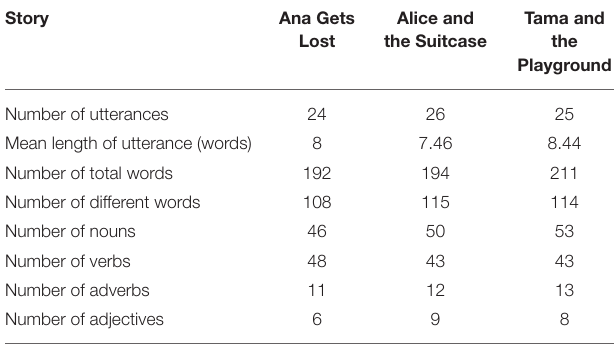
TABLE 2 | Comparison of linguistic features of three story retell